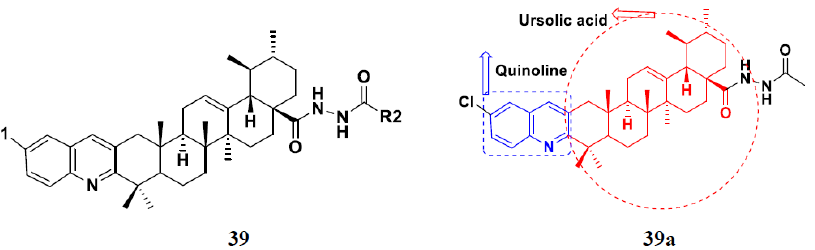
Figure 43. Structure of quinoline based ursolic acid hybrids and the most promising compound 39a . Table 32. In vitro cytotoxic activities of quinoline based ursolic acid hybrids compounds 39 ( b – e ).